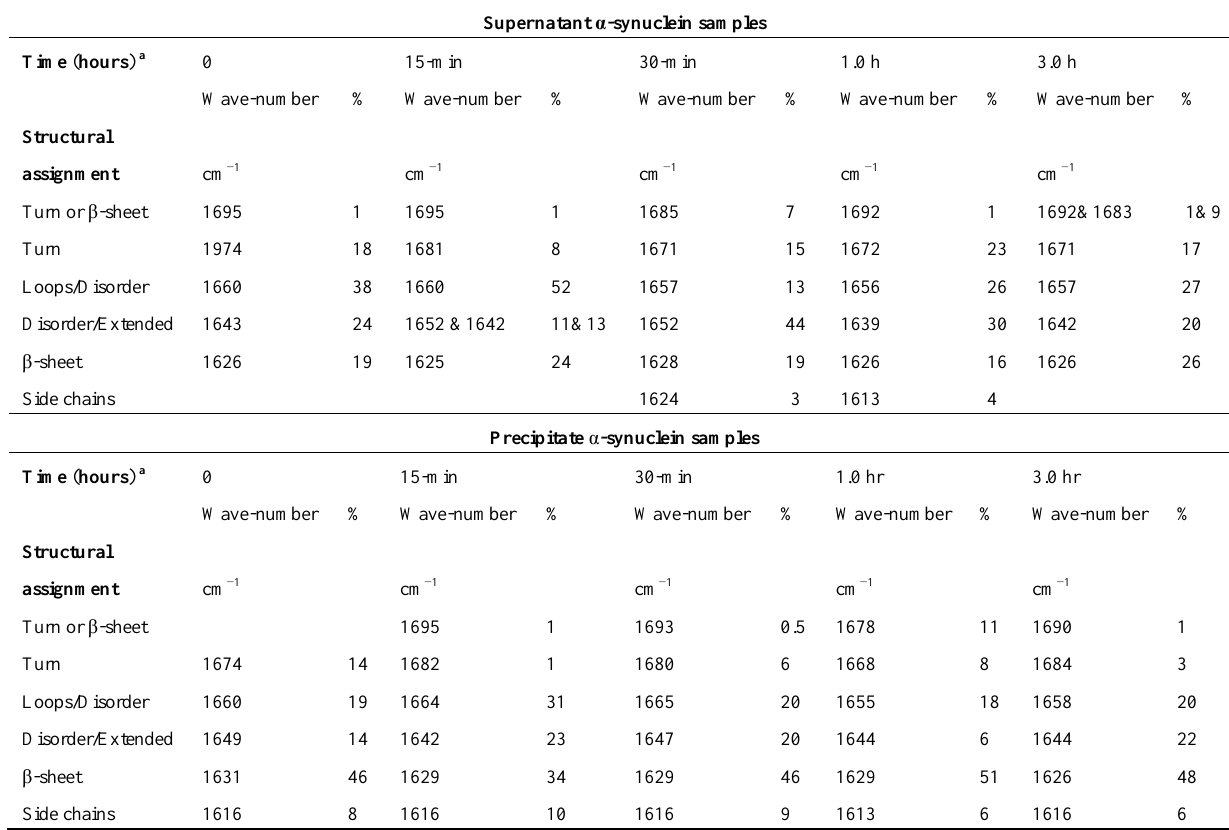
Table 3. ATR-FTIR-based evaluation of secondary structure content during the fibrillation process for human α-synuclein with rotenone introduced at selected time intervals and samples taken at the end of the fibrillation